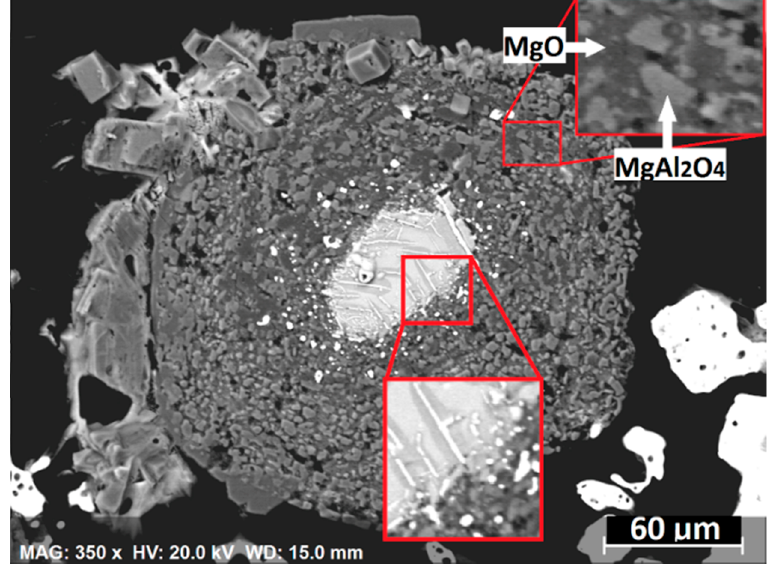
Figure 5. BSE image of a partially reduced chromite particle (180–300 µm) with a chromite core, illustrating the mechanism for the formation of discrete Fe-rich ferrochrome alloy particles.